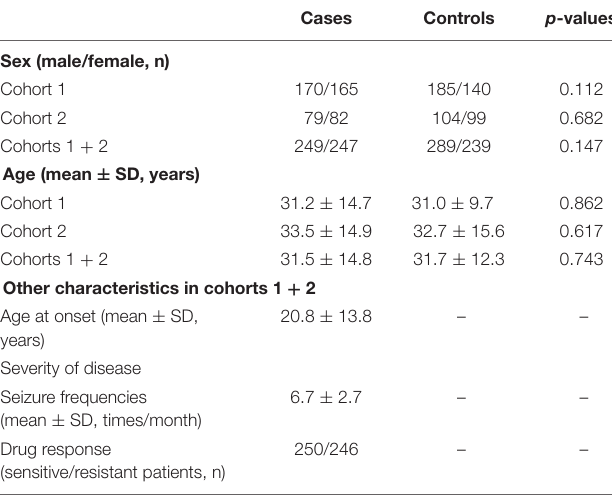
TABLE 1 | General characteristics of enrolled